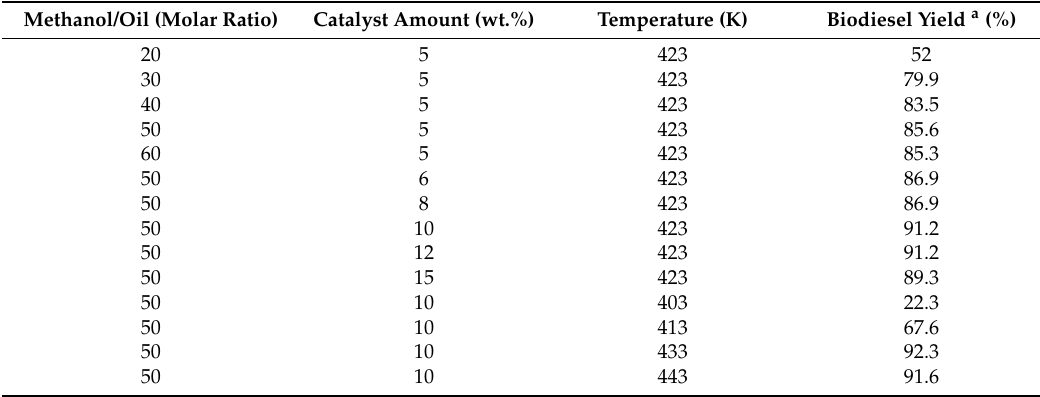
Table 10. Effects of reaction parameters on the performance of the